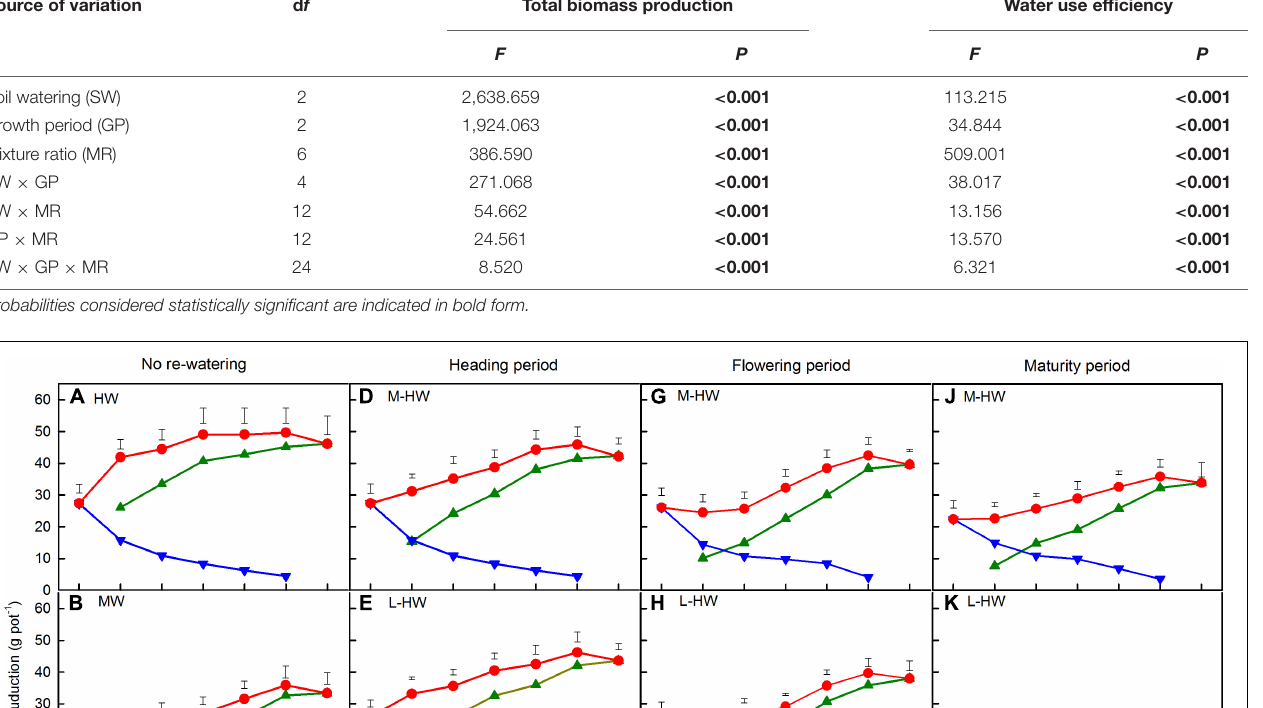
TABLE 1 | Effects of soil watering, growth period, mixture ratio, and their interaction in the three-way ANOVA on the total biomass production and water use efficiency (WUE) of both species. Source of variation d f Total biomass production